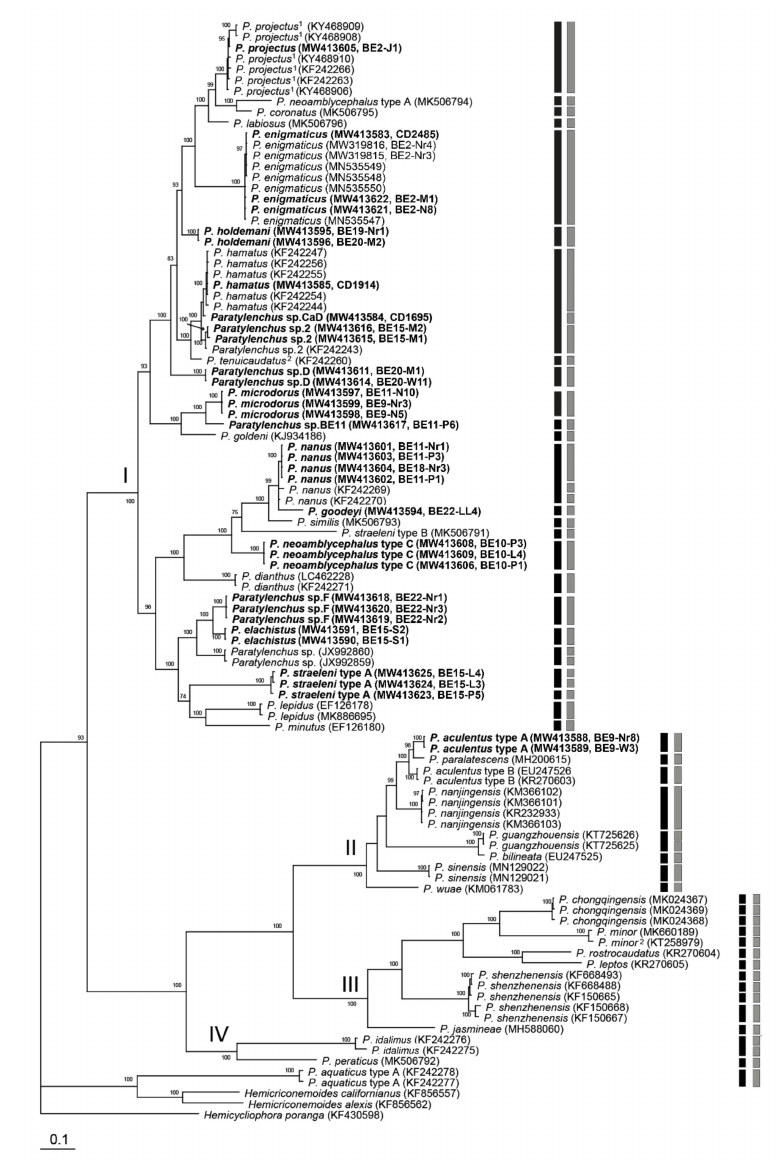
Figure 17. Phylogenetic relationships within populations and species of Paratylenchus as inferred from Bayesian analysis using the ITS rRNA gene sequence dataset with the GTR + I + G model. Posterior probability more than 70% is given for appropriate clades. Newly obtained sequences are indicated in bold. 1 = originally identified as P. nanus and 2 = originally identified as Paratylenchus sp. Black and grey bars represent species boundaries estimated by GMYC and bPTP methods,